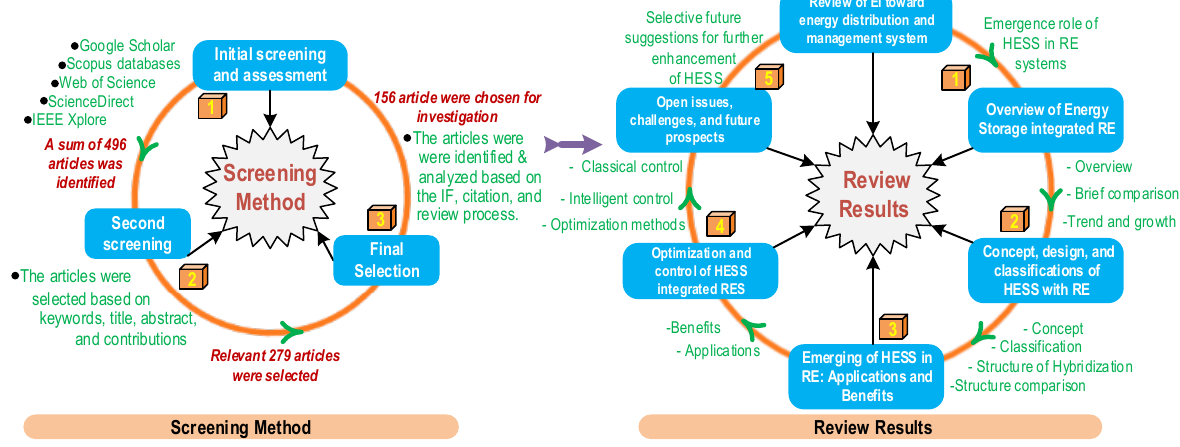
Figure 2. Schematic illustration of the reviewing methodology.